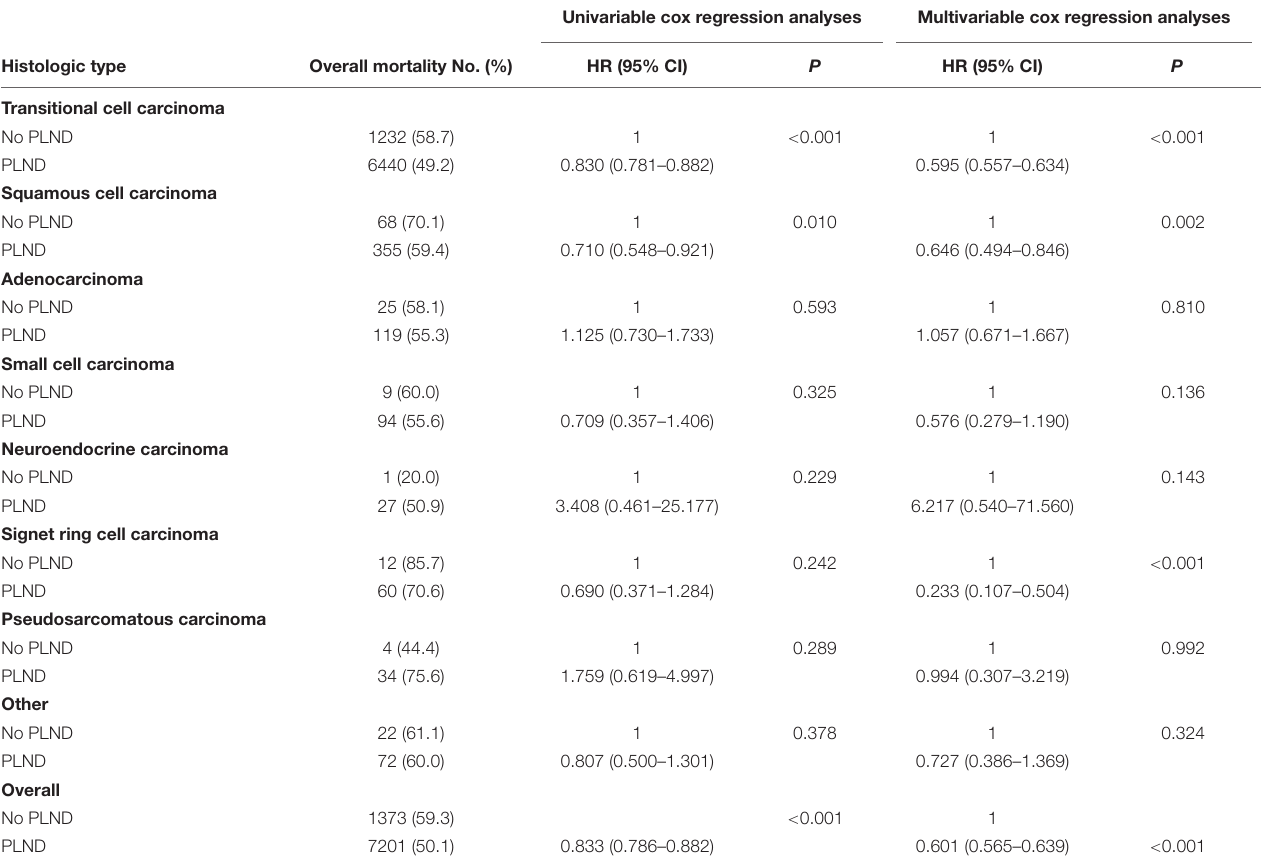
TABLE 4 | Overall mortality rate, univariable and multivariable cox regression analyses predicting overall survival in patients with carcinoma of the bladder with variant histology within the SEER between 2004 and 2015. Univariable cox regression analyses Multivariable cox regression